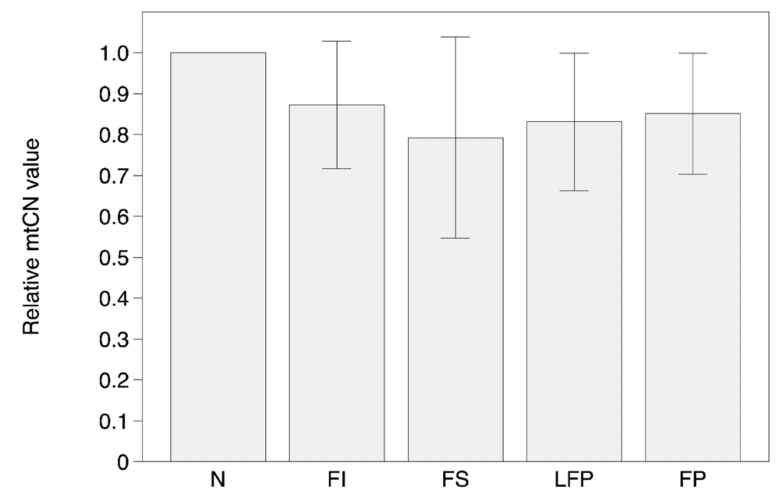
Figure 5. The relative mtCN values in una ff ected aortic intima (N) and di ff erent types of atherosclerotic lesions (FI, fatty infiltration; FS, fatty streaks; LFP, lipofibrous plaque; FP, fibrous plaque).